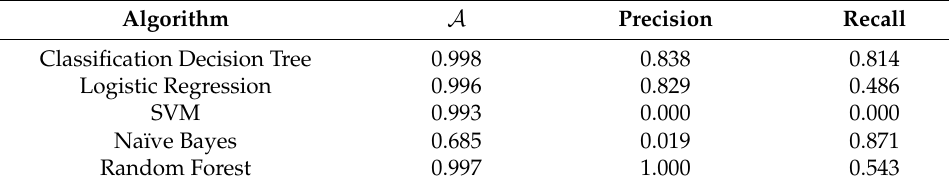
Table 2. Performance of classification algorithms.